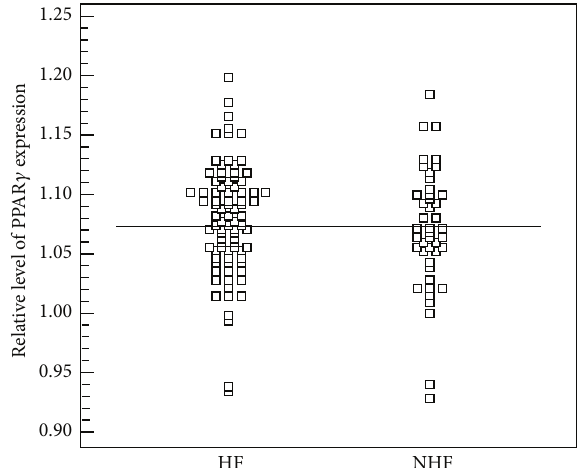
Figure 2: Level of expression of PPAR 𝛾 in left ventricle in the group with heart failure (HF) and without heart failure (NHF).